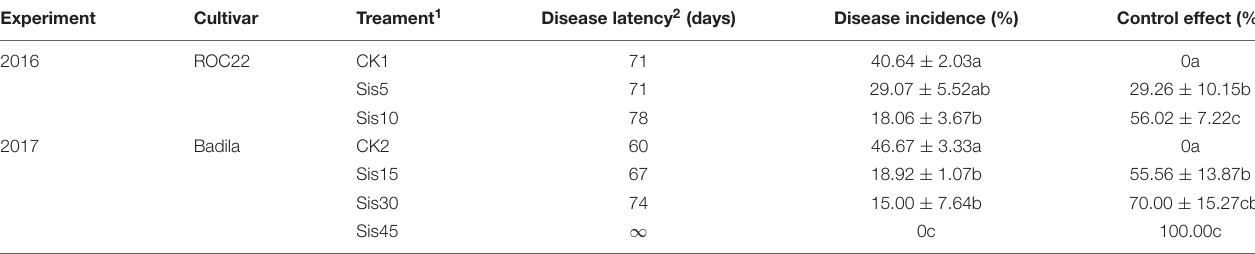
TABLE 1 | Effect of silicon on disease latency, disease incidence, and control effect under Sporisorium scitamineum stress.